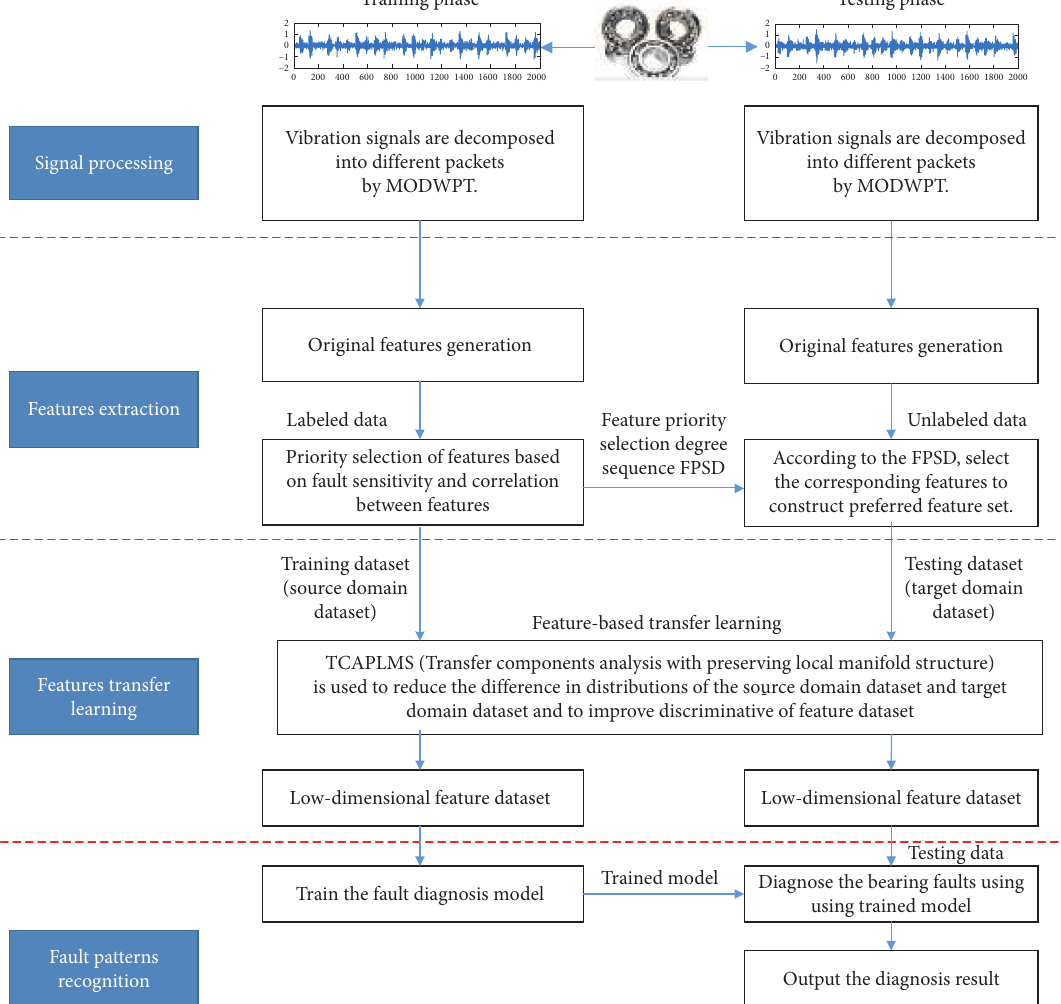
Figure 1: The frame structure block diagram of the proposed variable-condition bearing fault diagnosis system.